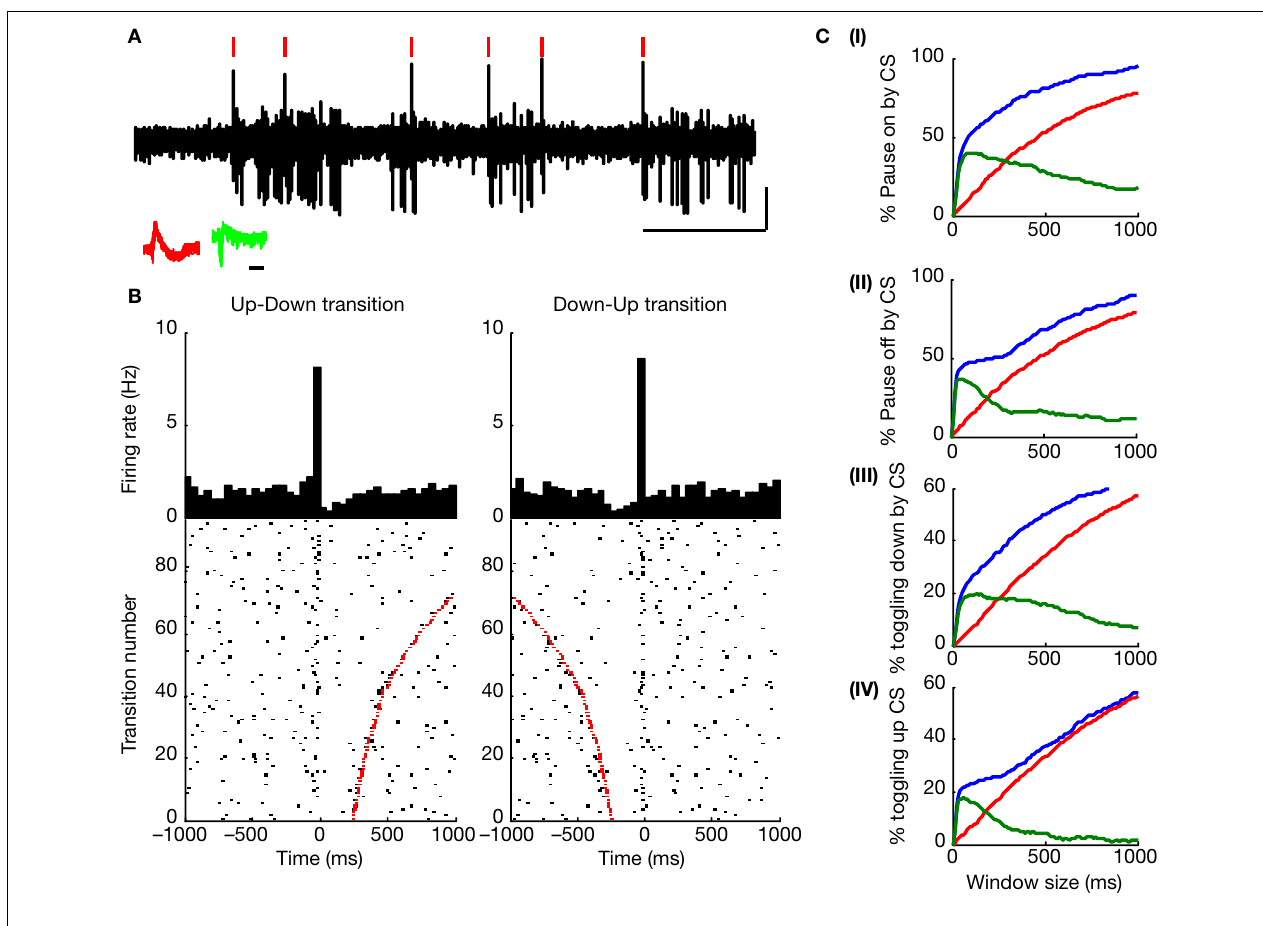
to the (III) down and (IV) up states as a function of window size, as observed for the original data of this cell (blue curve) in comparison to what would be expected by random (red curve). Green curve indicates the difference between the blue and red curves showing that the increased probability for state transitions to occur near CSs and vice versa does not depend on a highly specifi c window size, but rather holds for a range of window (a signifi cant difference, Figure 4A , p < 5e − 7). 12 ± 2.1% of all CSs (mean ± SEM) were associated with state transitions. This